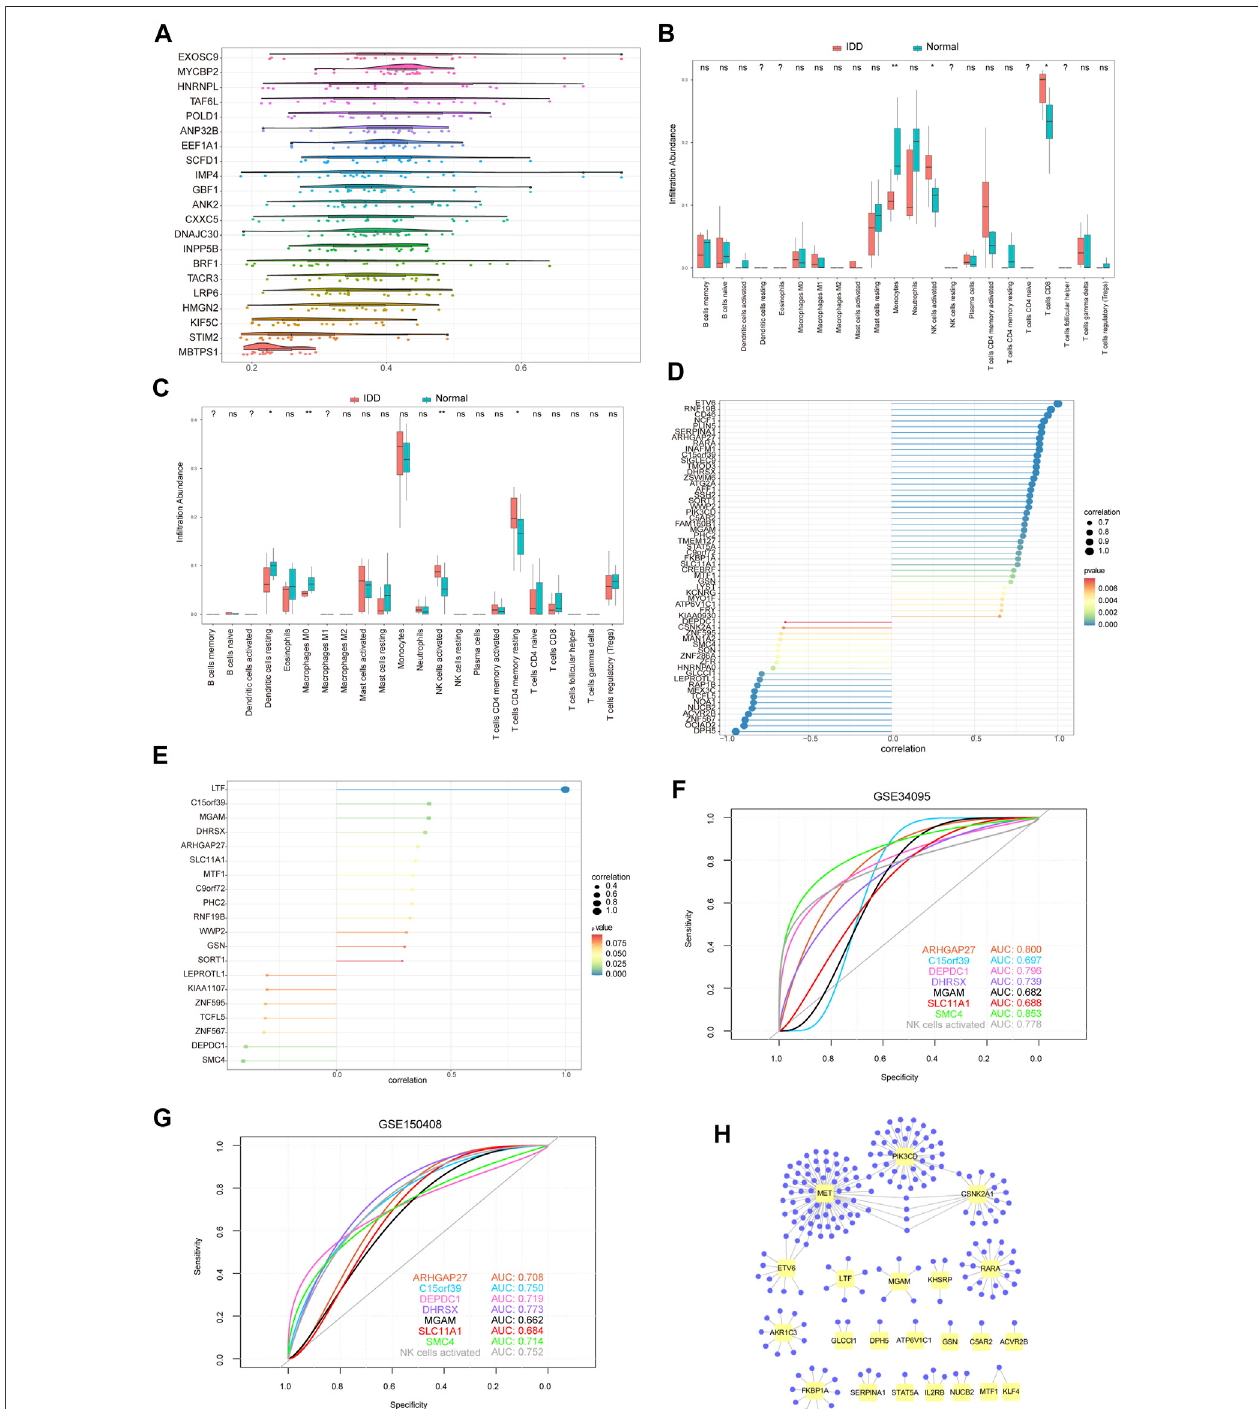
FIGURE10| Immune in fi ltration analysis ofhub genes. (A) Friend analysis of19 hub genes. The horizontalaxis represents the correlation strength, and the vertical axis indicates the gene name. (B) Immune in fi ltration analysis of 22 immune cells by 71 hub genes from the GSE124272 dataset. Pink indicates degenerative tissue of intervertebraldisc,andblue – greenindicatesnormaltissue. (C) Immunein fi ltrationanalysisof71hubgenesinto22immunecellsusingtheGSE150408dataset.Thepink color indicates IDD tissue, and theblue – green color indicates normal tissue. (D) Pearson correlation coef fi cient between active NK cellenrichment abundance and 58 hub gene expression values related to IDD. GSE124272 dataset, in which the node size indicates the absolute value of correlation and the node color indicates the signi fi cantcorrelation. (E) Pearsoncorrelationcoef fi cientbetweentheabundanceofactiveNKcellenrichmentandtheexpression valuesof20hubgenesrelated toIDD.